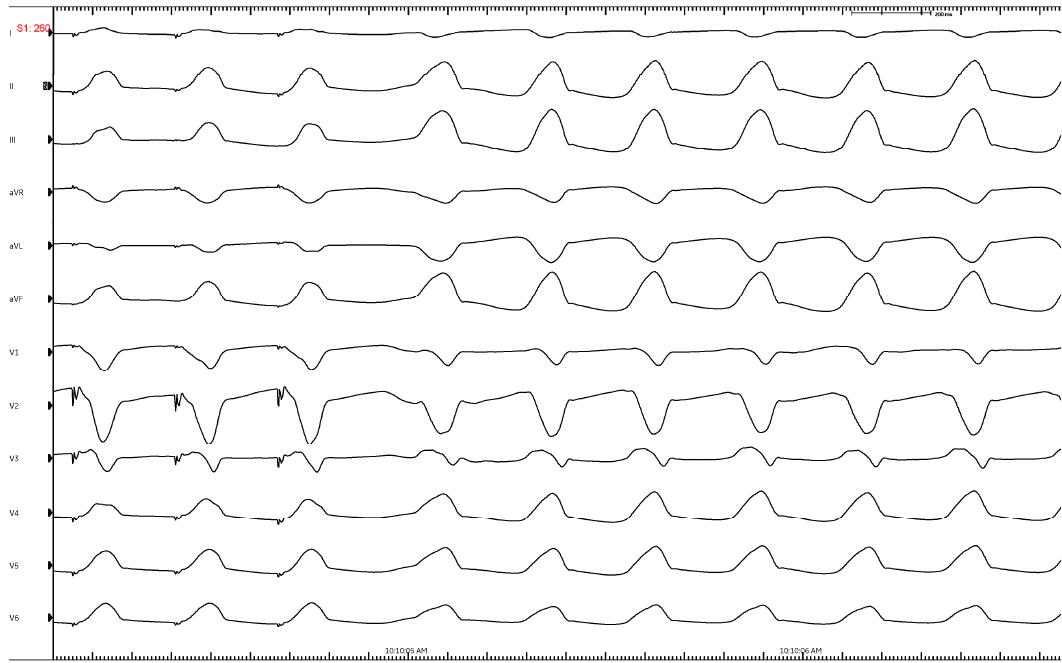
Figure 2. Characteristic ECG of an RVOT-VT showing LBBB, inferior axis, transition at V3, lead 1 is negative. Successful ablation was performed just below the pulmonary valve on the leftward free